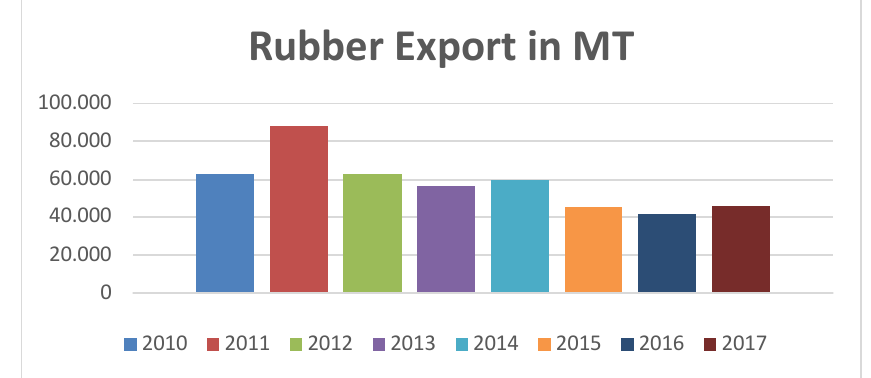
Figure 6 : Rubber export from Liberia in metric tons (CBL, 2010-2017)